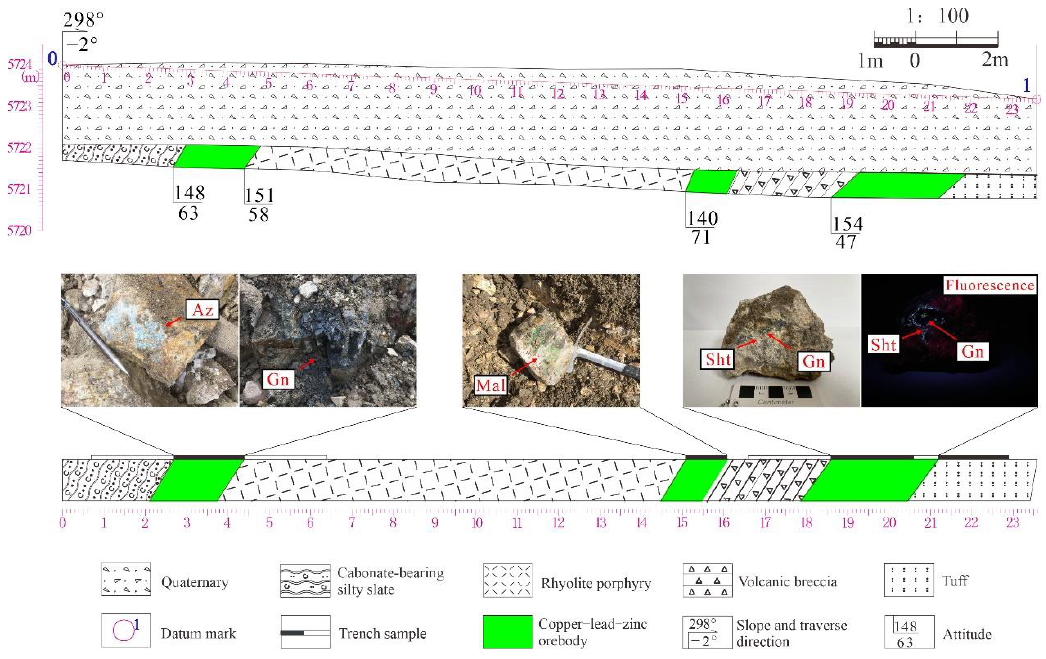
Figure 11. M-TC3 (0 – 1 traverse) trench cross-section and typical ore. Abbreviations: Gn, galena; Mal, malachite; Az, azurite; Sht, scheelite.